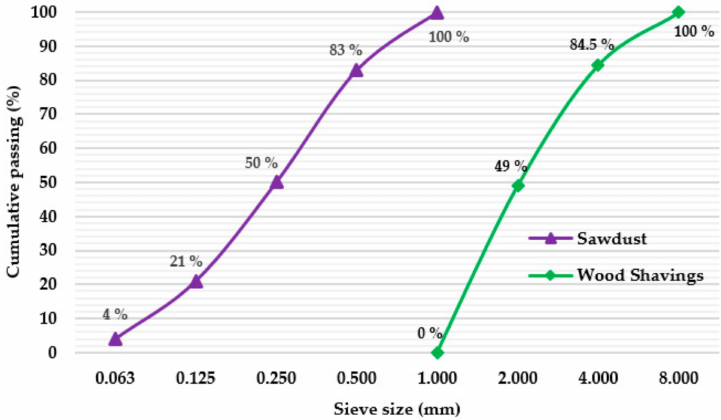
Figure 2. Particle size distribution of wood waste used as raw